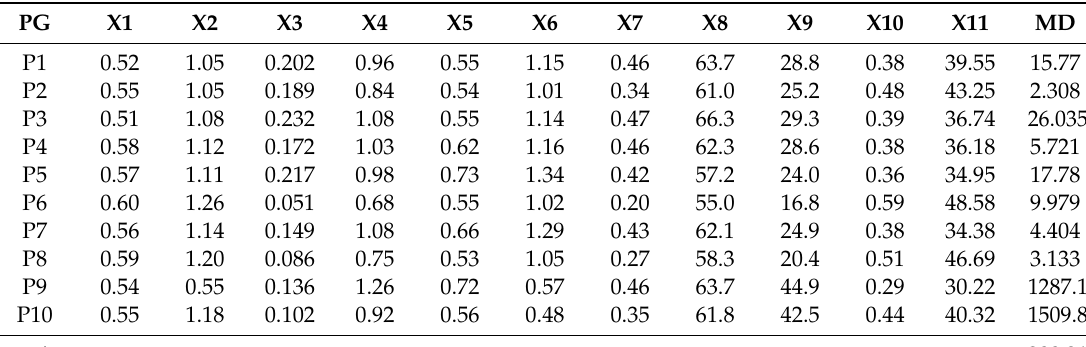
Figure 3. Mahalanobis distance (MD) for the healthy group (HG) and ACLR group (PG). Table 7. MD for ACLR group (PG)